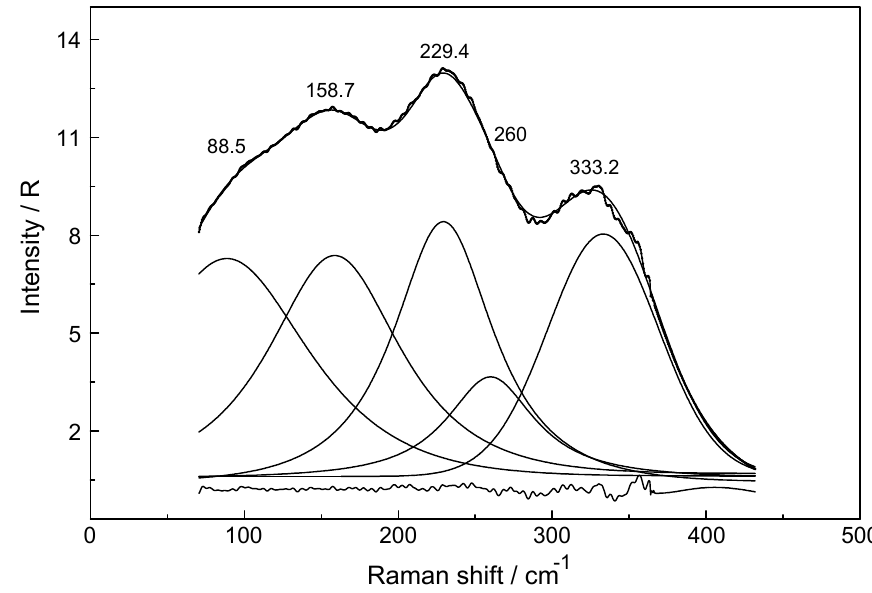
Figure 2. Result of a band fit of an anisotropic Raman scattering profile of a Yb(ClO 4 ) 3 solution at 2.423 mol·L − 1 in R-format. Shown are the measured spectrum, baseline corrected, the sum curve of the band fit and the band components. Underneath is the residue curve, which is the di ff erence of the measured spectrum and the sum